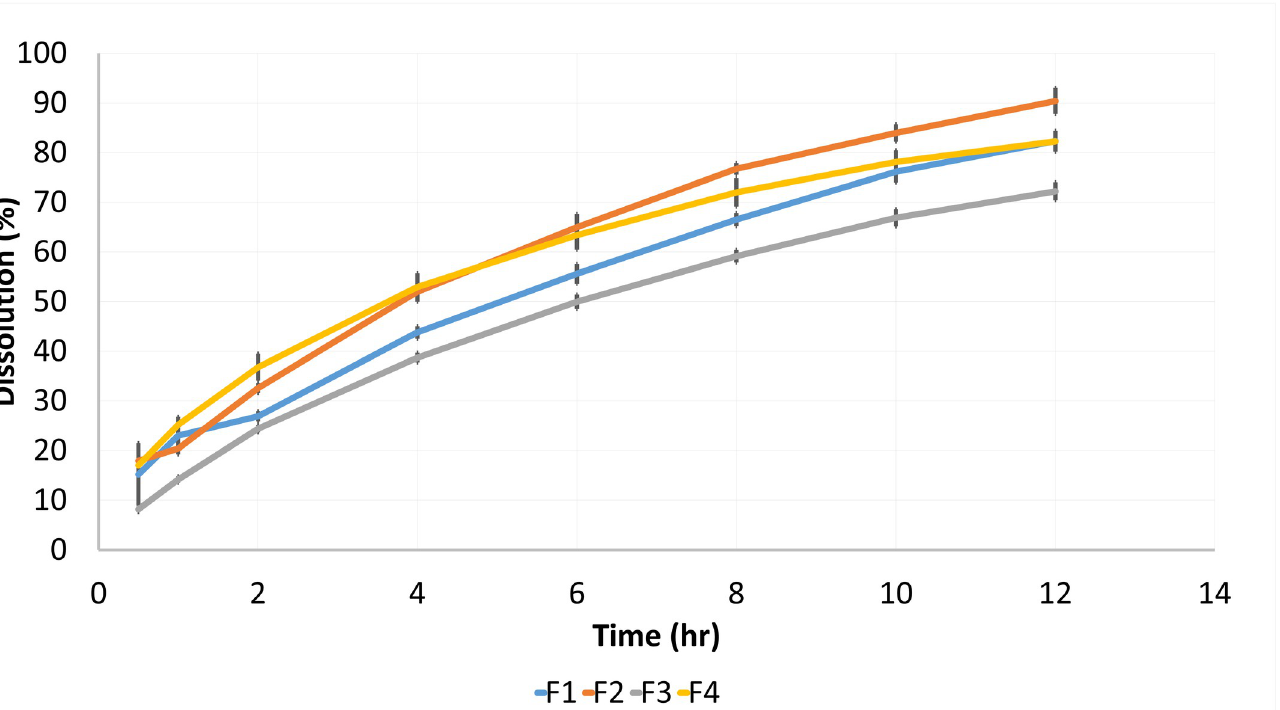
PLOS ONE | https://doi.org/10.1371/journal.pone.0271442 August 26,